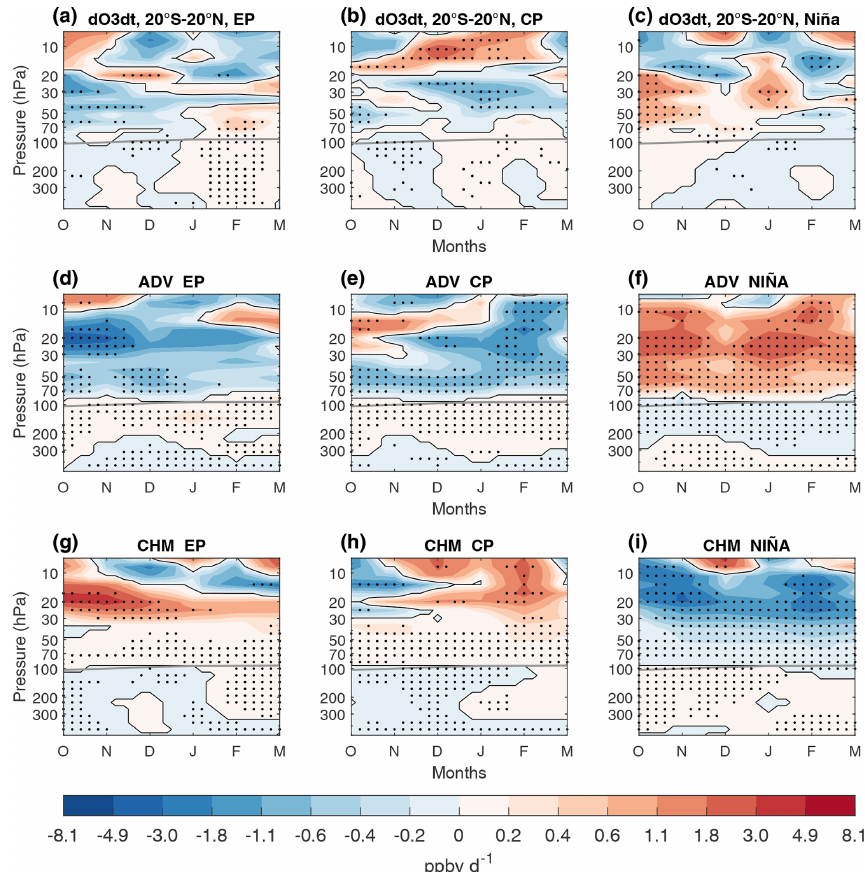
Figure 4. October–March composite evolution of the anomalies of the most relevant terms in the zonal-mean ozone continuity equation (Eq. 1) as a function of pressure, averaged over 20 ◦ S–20 ◦ N, for (from left to right) EP El Niño, CP El Niño and La Niña events. (a– c) DO3dt is the local tendency in the ozone mixing ratio. (d–f) ADV is variation due to the advection. (g–i) CHM denotes the chemical balance. Black dots denote statistically significant anomalies at the 95% confidence level. The tropopause is indicated by the thick grey